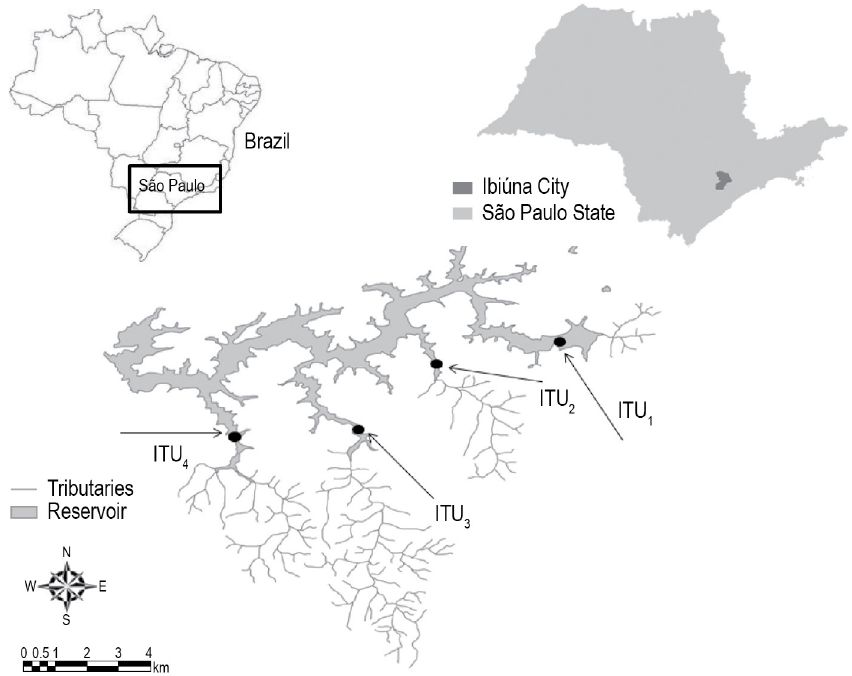
Figure 1. Location of the study area in Brazil, São Paulo State, including a map of the Itupararanga Reservoir with the sampling stations